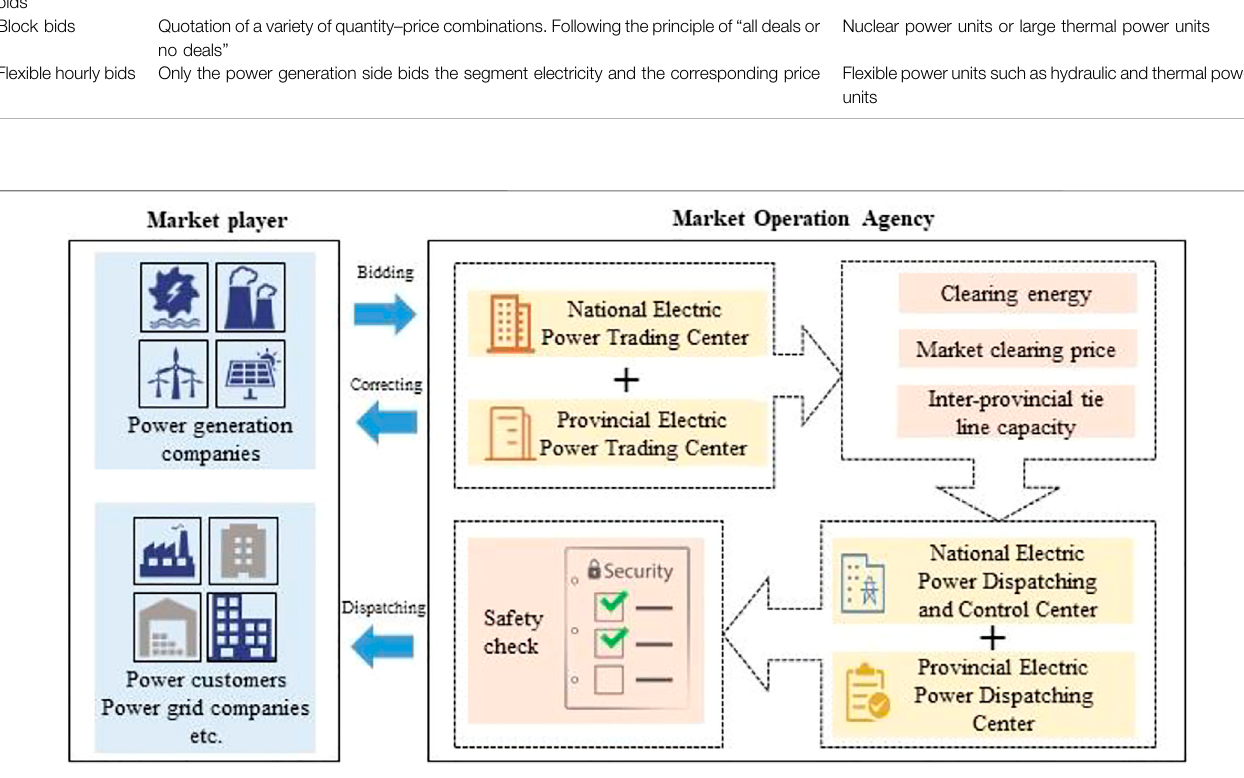
FIGURE 2 | Clearing mechanism of a two-tier electricity